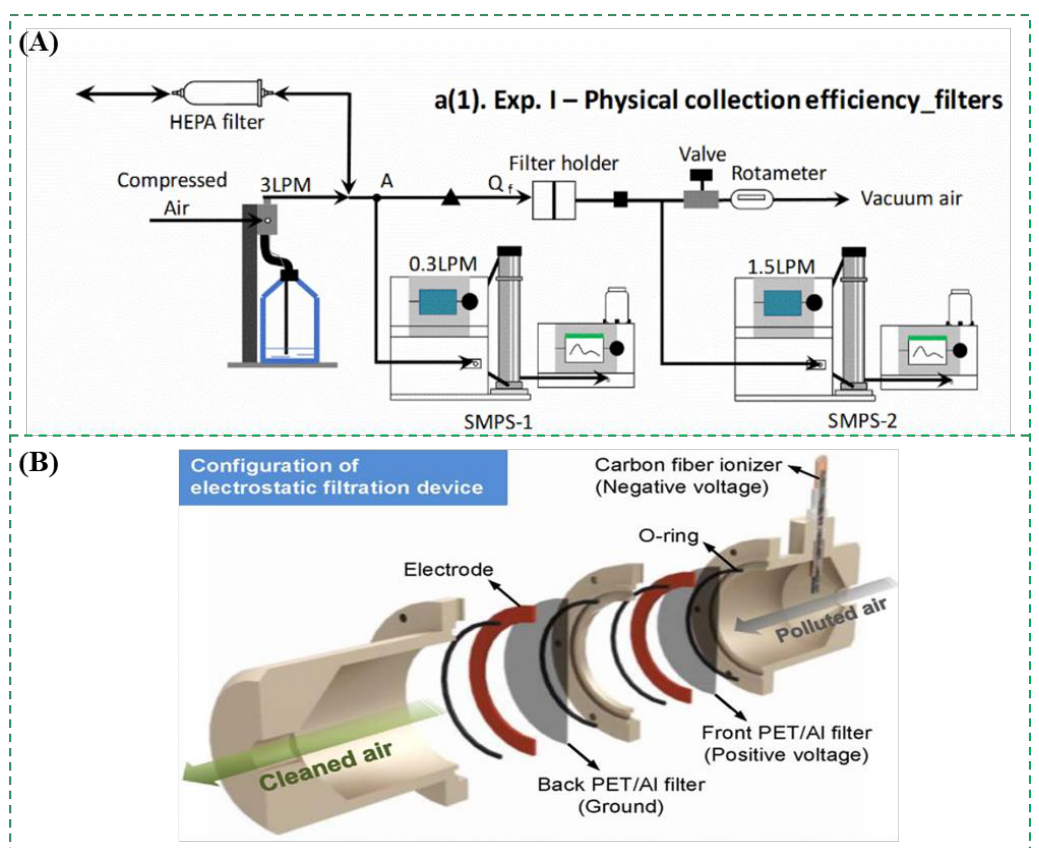
Figure 2. ( A ) The filtration method for collection of bioaerosols containing influenza virus. Reprinted with permission from ref. [39]. Copyright 2018 Elsevier B.V. ( B ) The filtration method for collection of bioaerosols containing Escherichia coli and Staphylococcus epidermidis . Reprinted with permission from ref. [40]. Copyright 2018 Elsevier B.V.